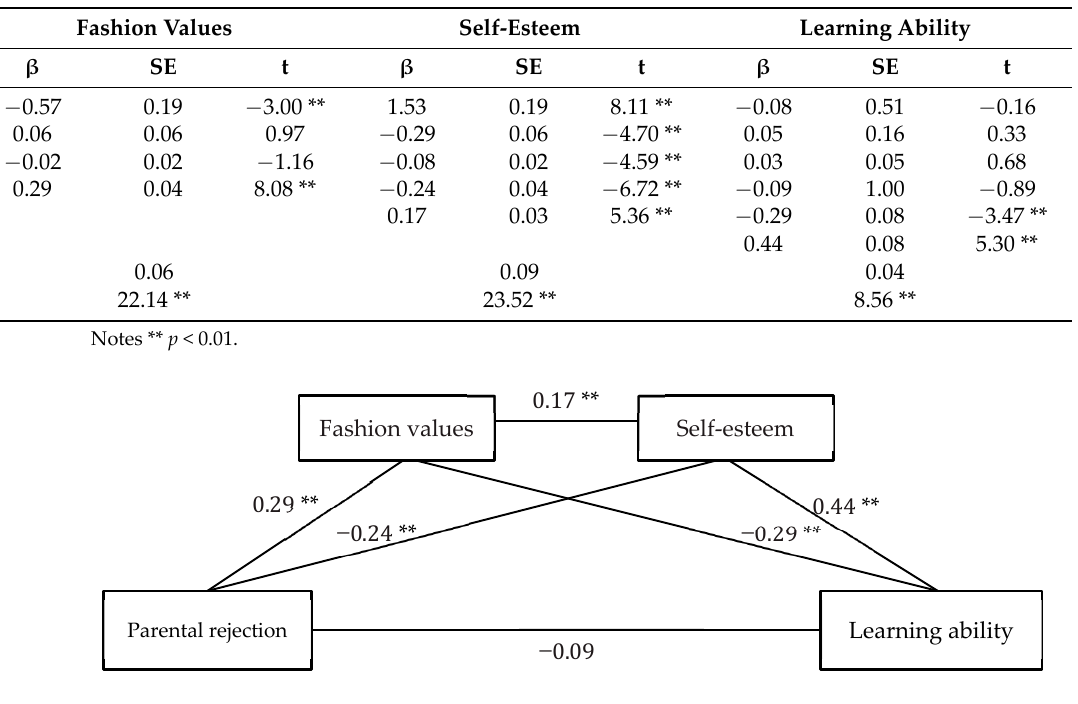
Figure 1. Multiple mediating model of parental rejection and learning ability. Notes ** p < 0.01.